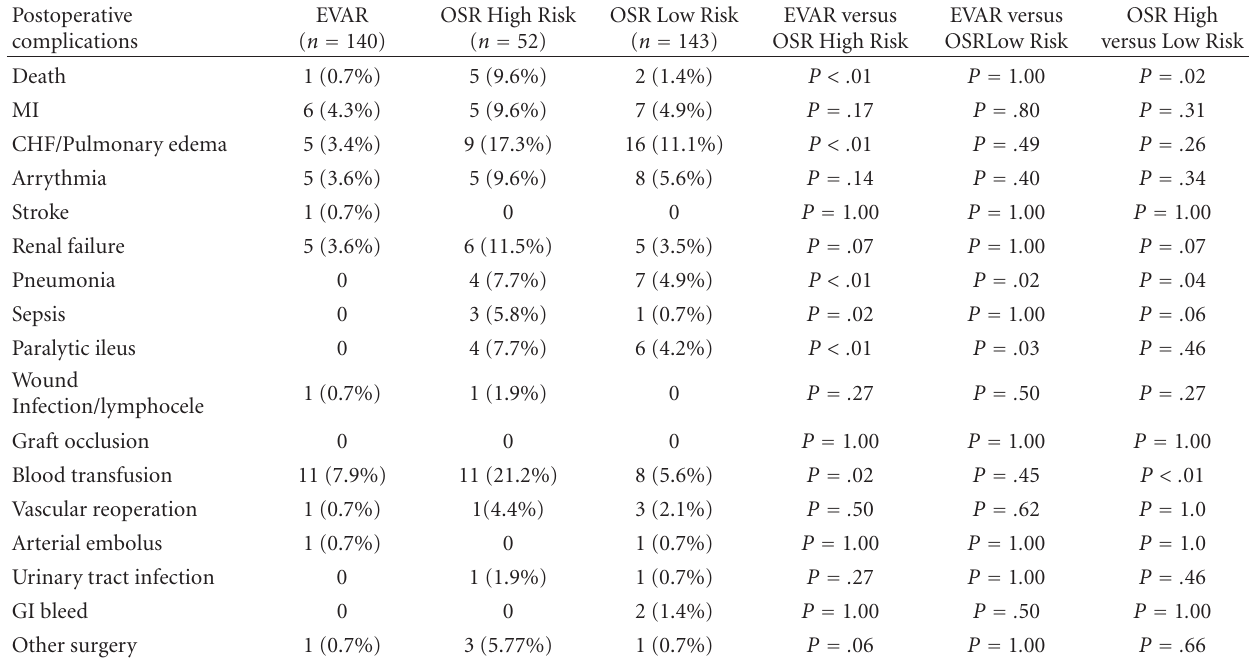
Table 2: Postoperative complications (30 days or to discharge).